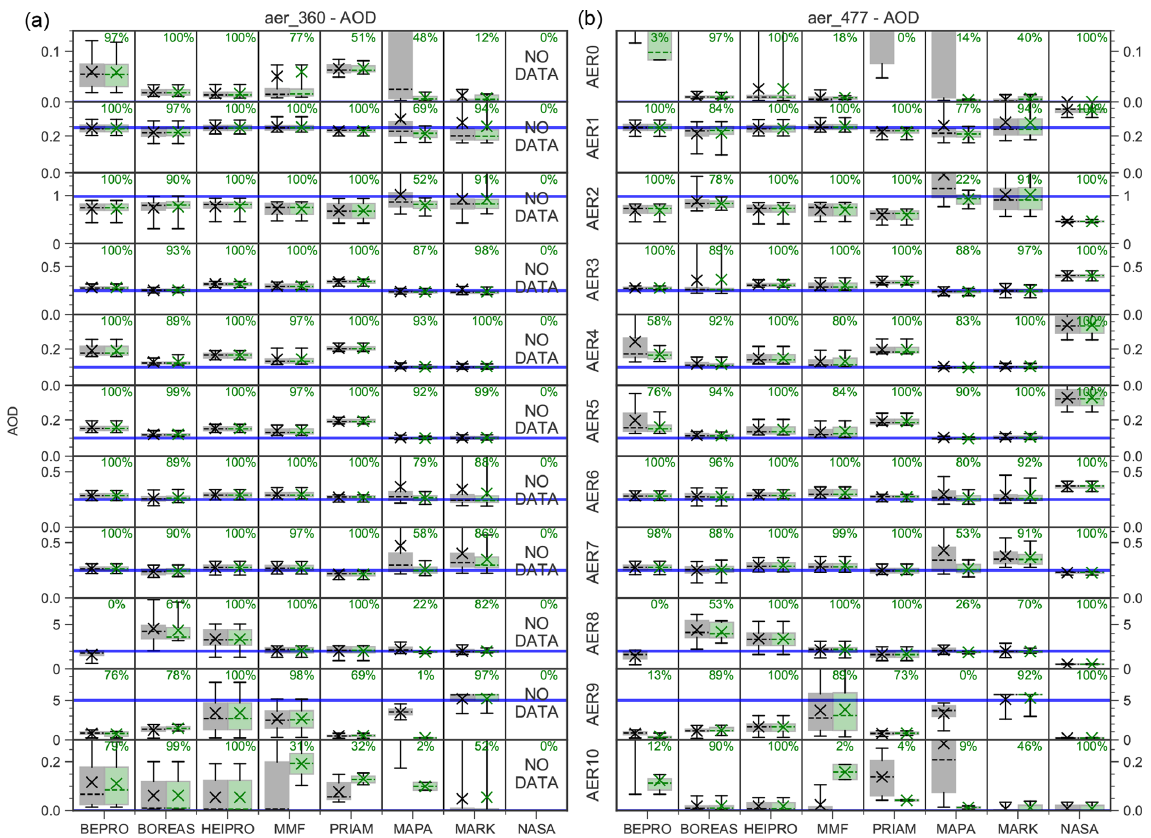
Figure 16. Box–whisker plots of the retrieved AOT at 360 (a) and 477nm (b) for the different aerosol scenarios (rows) and retrieval algorithms (columns) based on retrievals using noisy dSCDs. Crosses show the mean and dashed horizontal lines the median. Shaded areas indicate the (25%–75%) percentile, and whiskers show the (5%–95%) percentile. The true AOT is shown as the blue horizontal line. For each algorithm, all data are shown on the left in black, and data marked as valid are shown on the right in green. Also shown is the percentage of valid